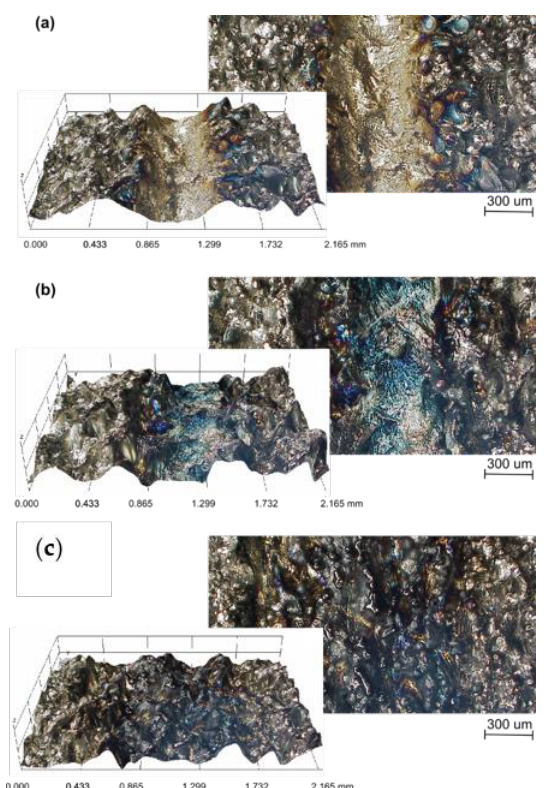
Figure 2. Laser tracks on the surfaces of specimens performed at: ( a ) Fd = 5 mm, ( b ) Fd = 7.5 mm, ( c ) Fd = 10 mm.